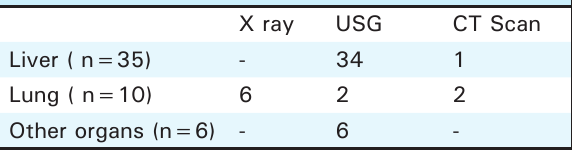
Table 4. Type of radiological imaging done in all cases. X ray USG CT